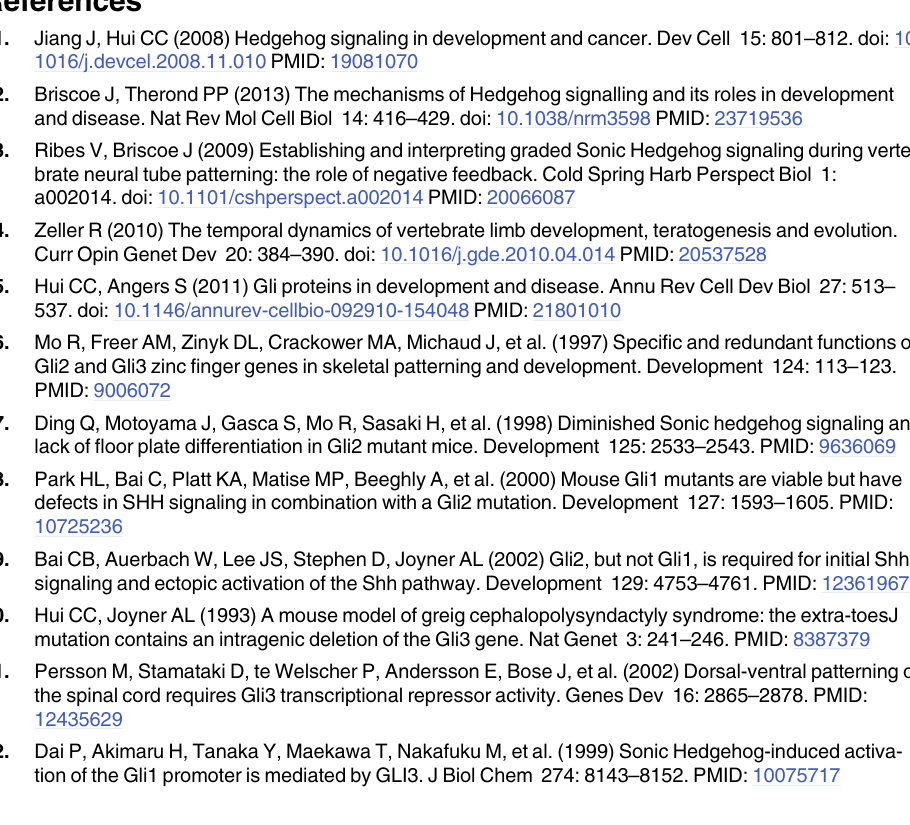
S1 File. Materials and Methods, Table A-F, References, S1 – S8 Fig. Legends. Table A: Sum- mary of identified mutations for the Sufu and Smo genes. Table B: Quantification of band in- tensity from Western blotting. Table C: Primer sequences for mutation screening. Table D: Summary of TGCE screening in the Sufu and Smo genes. Table E: Primers used for genotyping by pyrosequencing. Table F: Taqman probes and primer sequences for